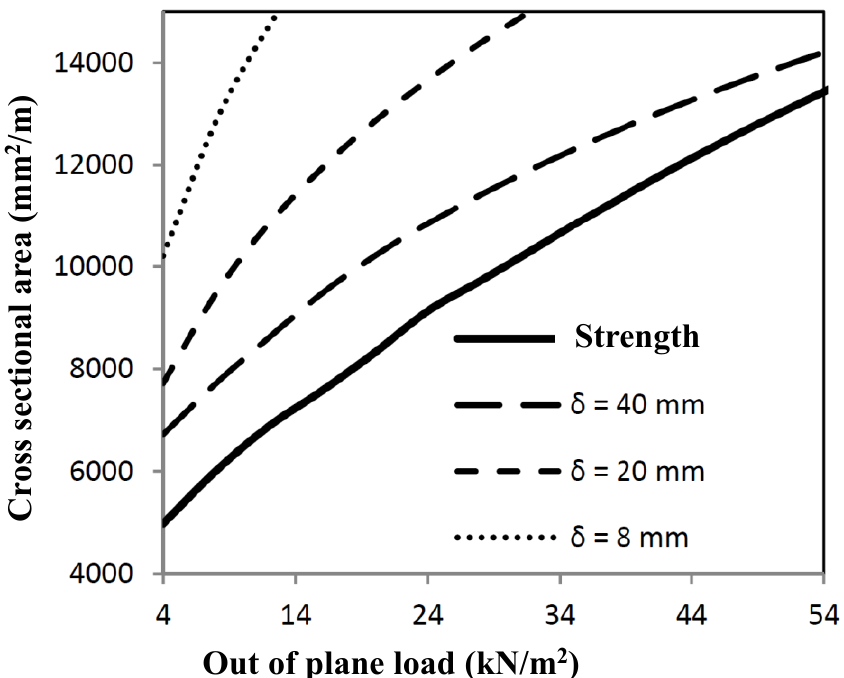
Figure 5. Minimum cross-section necessary for out-of-plane load combinations, where δ is the considered maximum allowable out-of-plane